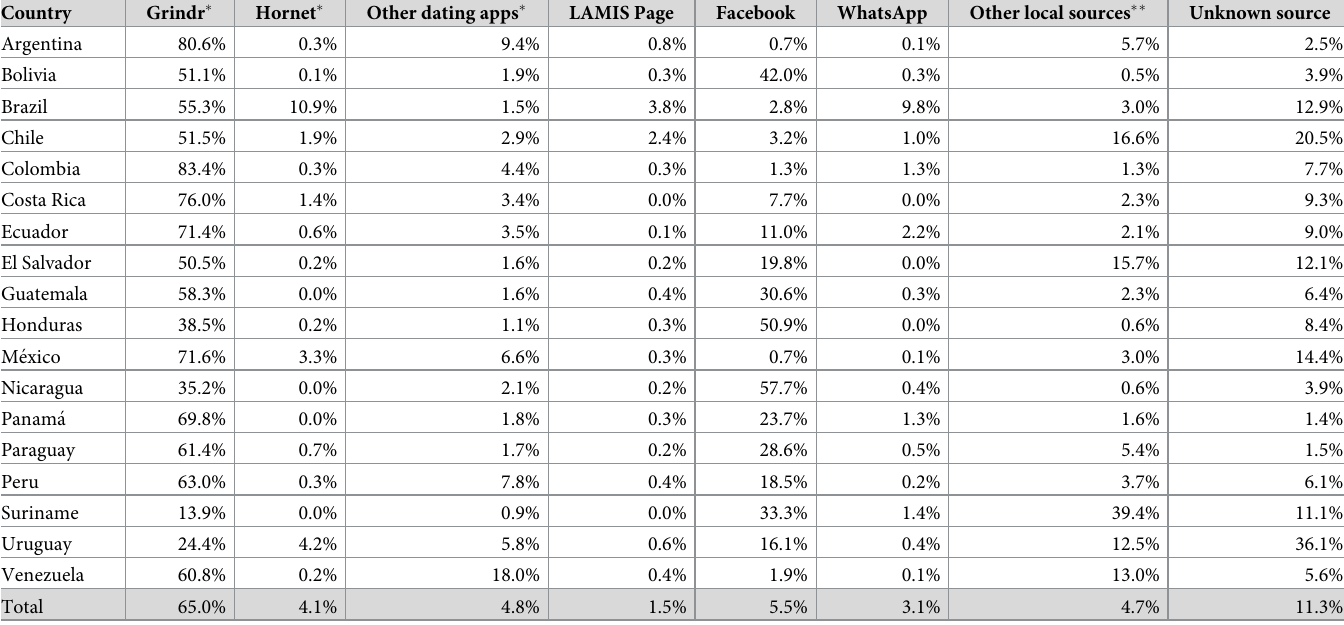
Table 3. Recruitment sources used in LAMIS-2018 by